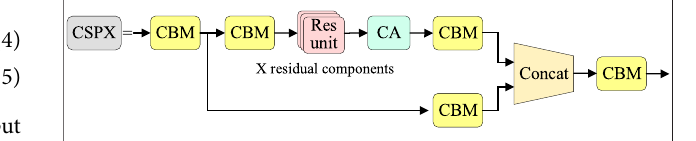
FIGURE 3 | Improved CSP